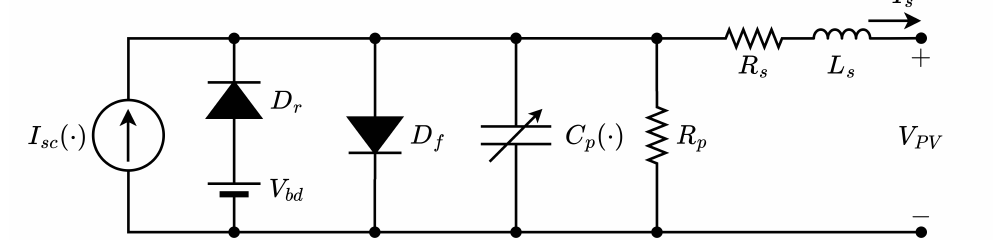
Figure 4. An example of a photovoltaic model which incorporates voltage-dependent capacitance, as well as improved reverse-bias, characteristics. Developed from